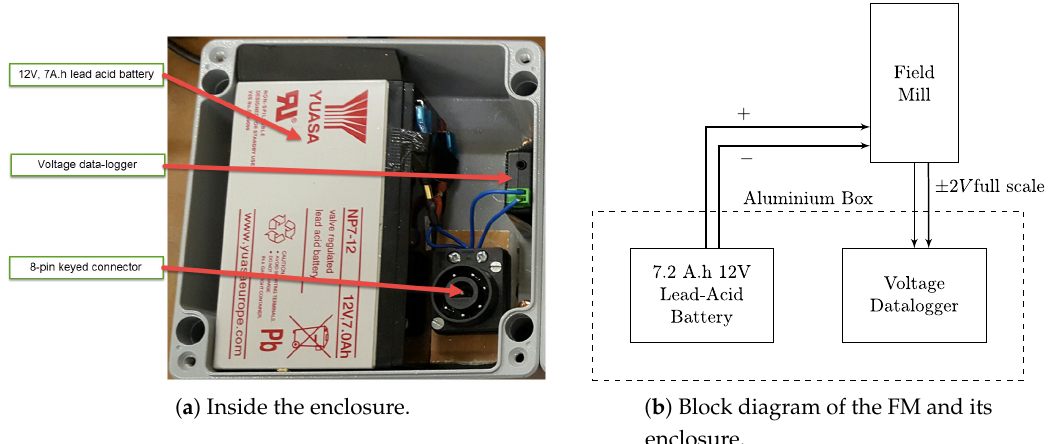
Figure 3. Experimental apparatus—showing the FM, the enclosure (housing the lead acid battery and temperature/humidity sensor). The FM sits above the box and is connected via a DIN connector through a small hole.